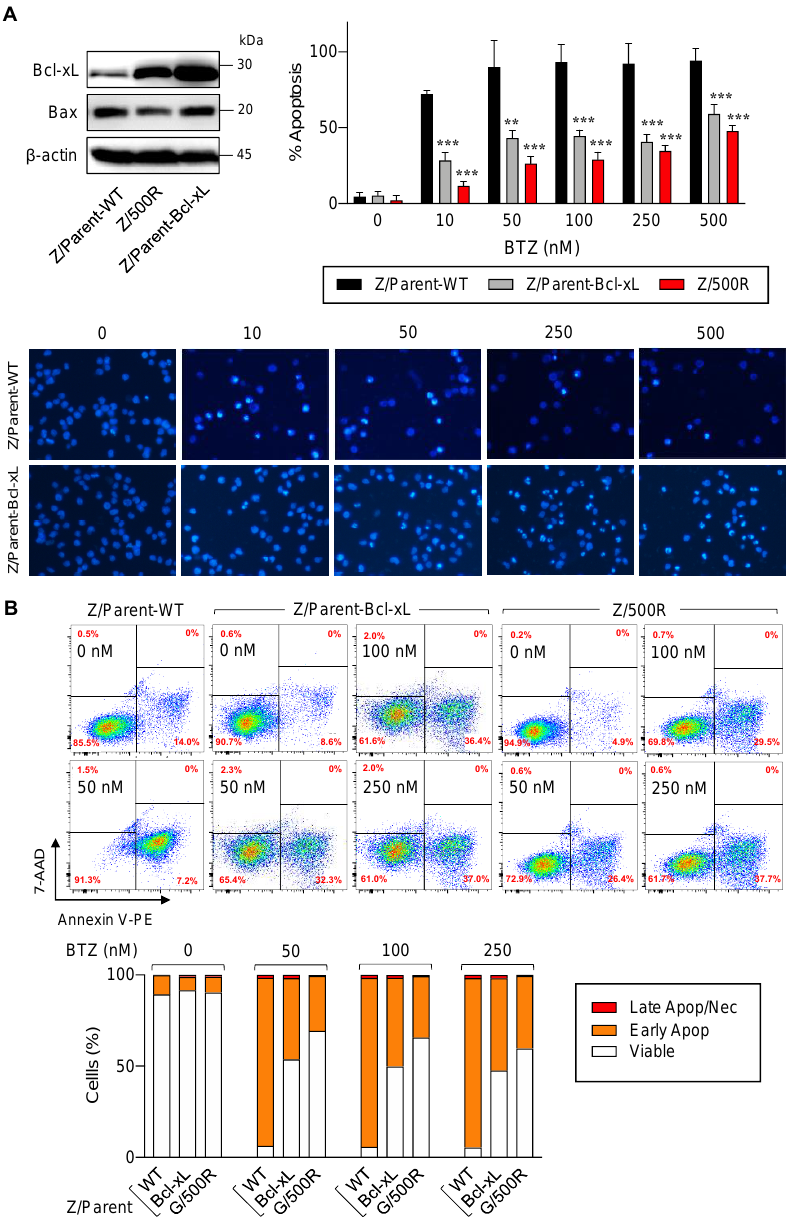
Figure 6. Bcl-xL is a key mediator of BTZ-induced apoptosis. Parental Z/Parent cells were transduced with Bcl-xL retroviral particles or control particles (WT) and treated with BTZ (0–500 nM) for 24 h. ( A ) Upper left : Western blot analysis of Bcl-xL level, along with Bax level, in Z/Parent-WT and Z/Parent-Bcl-xL cells in comparison to the highly BTZ-resistant Z/500R cells prior to experiments. Upper , right : Percentages of apoptosis as evaluated by Hoechst 33342 assay were scored and plotted. Data are mean ± SD ( n = 3). ** p < 0.01, *** p < 0.001 versus Z/Parent-WT cells; two-sided Student’s t -test. Lower : Representative micrographs of Hoechst 33342 nuclear staining under an inverted fluorescence microscope. ( B ) Analysis of cell death by Annexin V/7-AAD assay. Percentages of Annexin V single-positive cells defining early apoptosis, and Annexin V and 7-AAD double-positive cells defining late apoptosis/necrosis combining with 7-AAD single-positive cells defining necrosis were